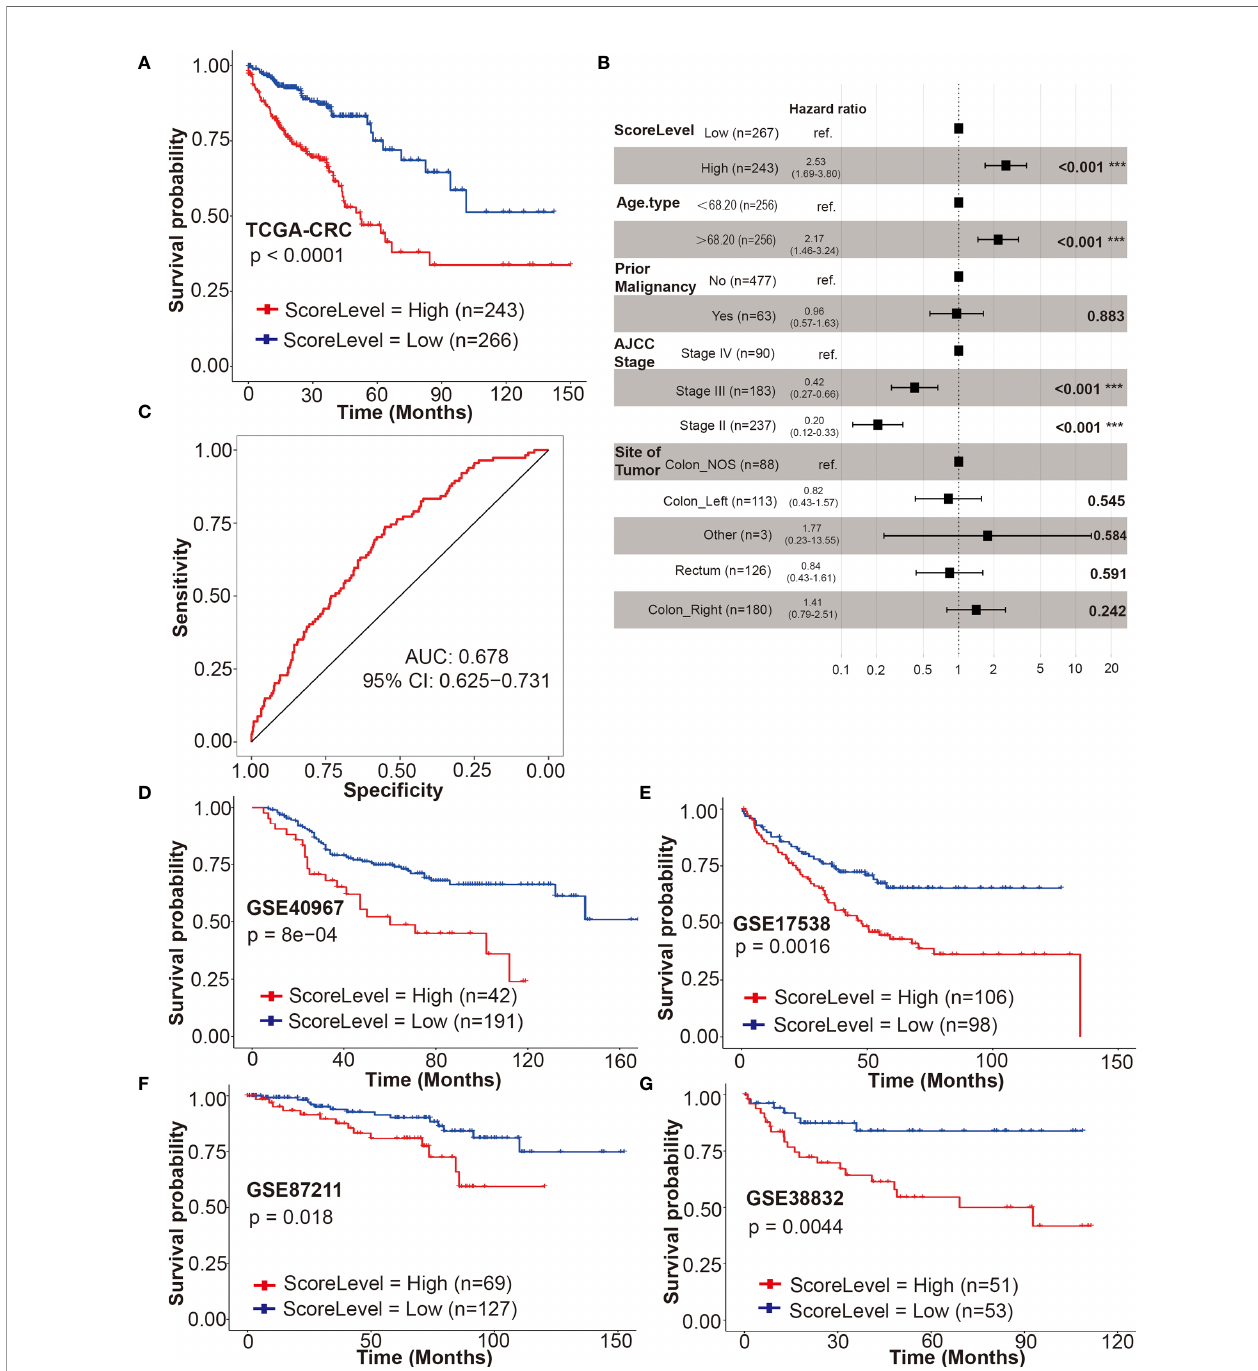
FIGURE 6 | Validation of the DRSM. (A) Univariate analysis for drug-resistant score (DRS) (high or low) and its correlation with clinical outcome [overall survival (OS)] in TCGA-CRC cohort. (B) Multivariate analysis after adjustment revealed DRS, age, and AJCC stage were independent prognostic factors for OS in TCGA-CRC cohort, and prior malignancy and site of tumor lost their signi fi cance. (C) Receiver operating characteristic (ROC) curve (AUC = 0.99) indicated that DRSM had favorable prognosis predictive performance in TCGA-CRC dataset. AUC indicates area under the curve. (D – G) Univariate analysis for DRS (high or low) and its correlation with clinical outcome (OS or DSS) in GSE40967, GSE17538, GSE87211, and GSE38832 datasets, respectively. *** P < 0.001. TCGA, the cancer genome atlas; CRC, colorectal cancer; AJCC, American Joint Committee on Cancer; NOS, not otherwise speci fi ed; AUC, area under the curve; CI, con fi dence interval; GSE, gene expression omnibus series; DRSM, drug-resistant score model; DRS, drug resistant score; OS, overall survival; ROC, receiver operating characteristic; DSS, disease free